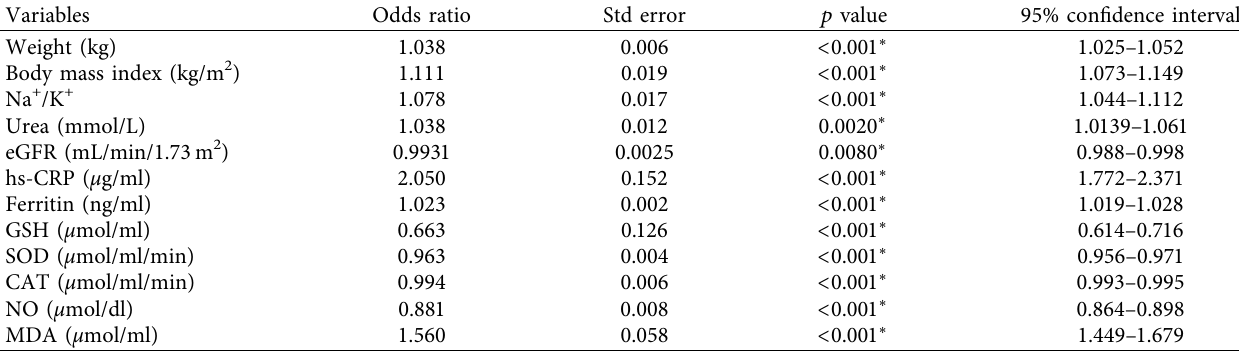
Table 5: Logistic regression analysis on independent variables predicting the odds of hypertension and its